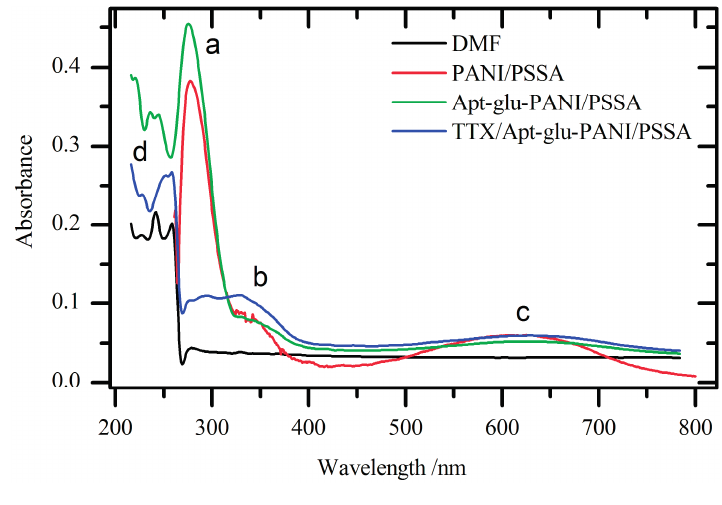
Figure 3. UV-Vis spectra of PANI/PSSA, Apt-NH 2 -glu-PANI/PSSA, and TTX-Apt-NH 2 -glu-PANI/PSSA composite materials dispersed in